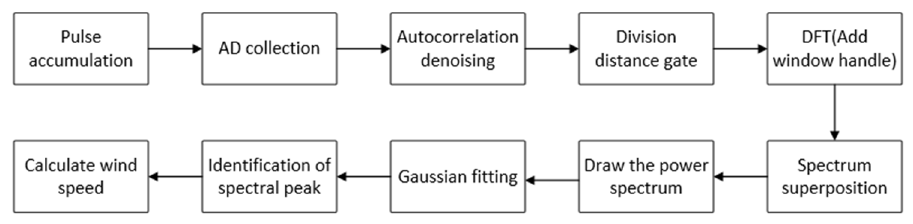
Figure 3. Data processing flowchart.